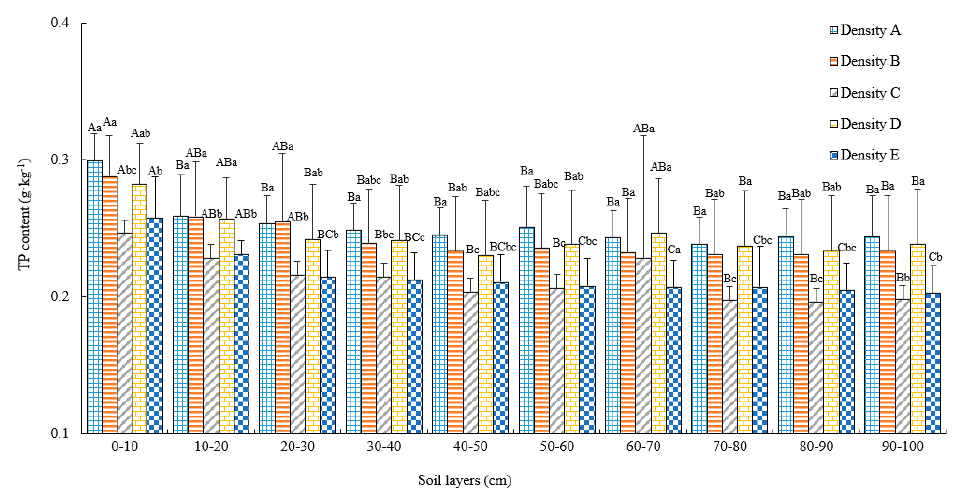
Figure 5. Soil total P in different layers under different stand densities (g·kg − 1 ). Note: different lowercase letters indicate significant differences among different densities at the 0.05 level, and different capital letters of the same density indicate significant differences among different soil layers at the 0.05 level.